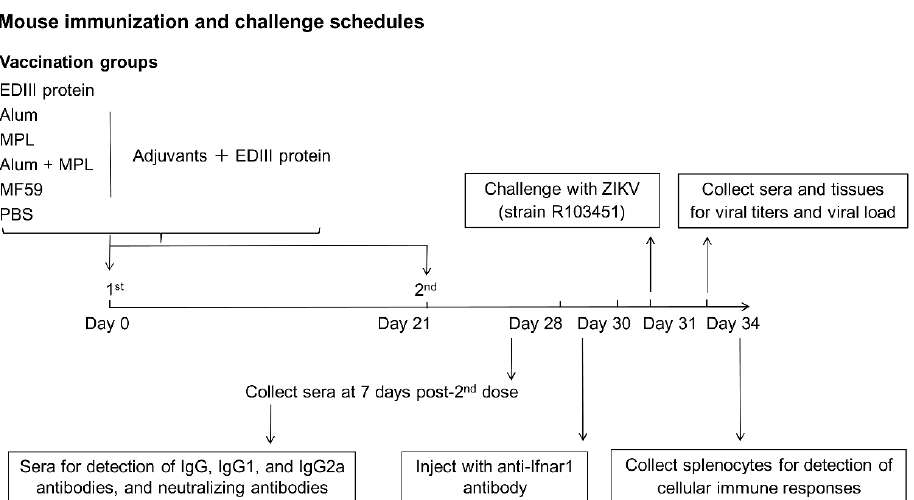
Figure 1. Immunization and challenge schedule. Mice were immunized intramuscularly (i.m.) with PBS (background control) or with ZIKV EDIII without an adjuvant, or with aluminum salts (Alum), monophosphoryl lipid A (MPL), Alum + MPL, or MF59 adjuvant and boosted at day 21 after the initial dose. Sera were collected at seven days after the boost (day 28) and used to determine ZIKV E or EDIII-specific antibody, and neutralizing antibody levels. Mice were injected with an anti-interferon- α / β receptor 1 (Ifnar1) antibody (in order to become susceptible to subsequent ZIKV infection) [36,37] at nine days after the boost (day 30) and subsequently challenged with ZIKV (strain R103451, 6 × 10 5 plaque-forming unit (PFU)) the following day (day 31). Sera and tissue samples were collected three days post-challenge (day 34) and used to determine ZIKV titers and viral load (RNA copies). Splenocytes were also tested for the ZIKV EDIII-specific cellular immune response.